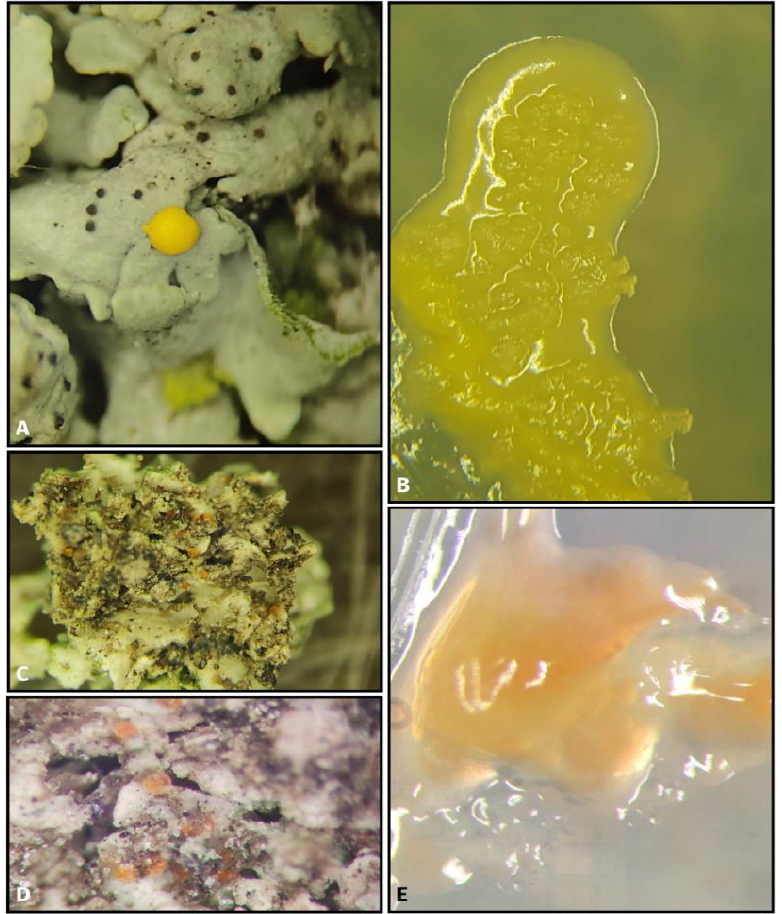
Figure 2. Lichen-associated yeasts. ( A ) Tremellomycetes growing on upper surface of Physcia sp. thallus and ( B ) isolated on PDA; ( C , D ) Tremellomycetes growing on the under surface of Physcia sp. thalli and ( E ) isolated on PDA.